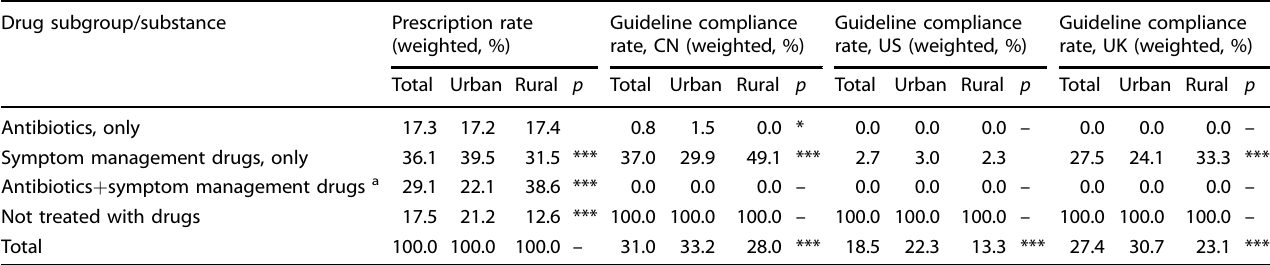
Table 4. Overall prescribing patterns and guideline compliance for adult acute bronchitis at primary healthcare in China. Drug